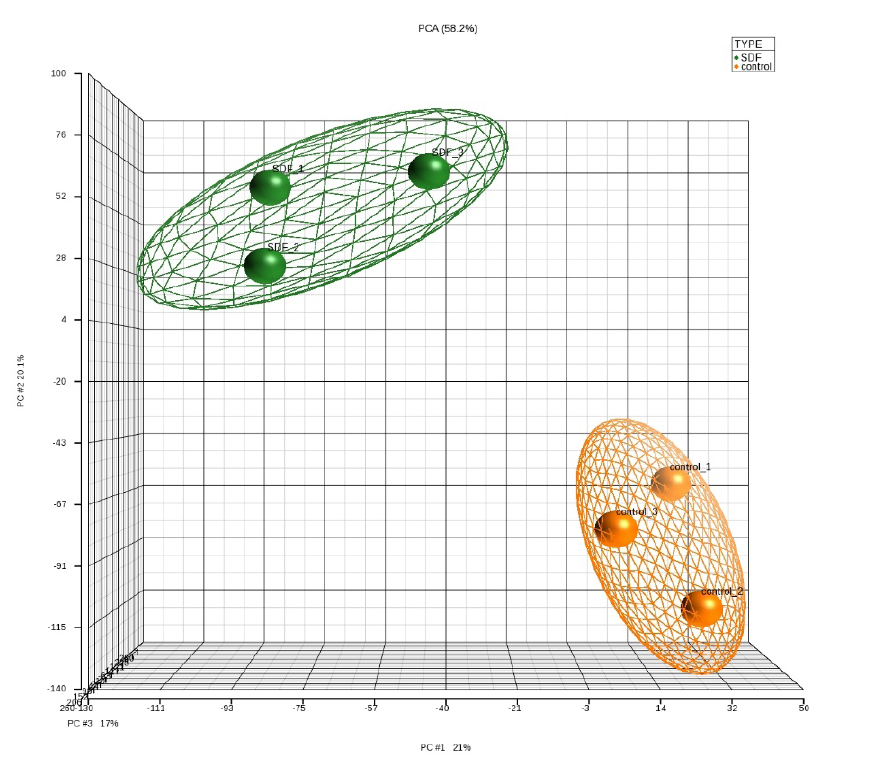
Figure 2: Primary component analysis mappings of SDF-1 treated human BMSCs versus control. SDF-1 treatment and control group show a unique miRNA clustering pattern for each group. Differential expression pattern confirms that seen in miRNA heat